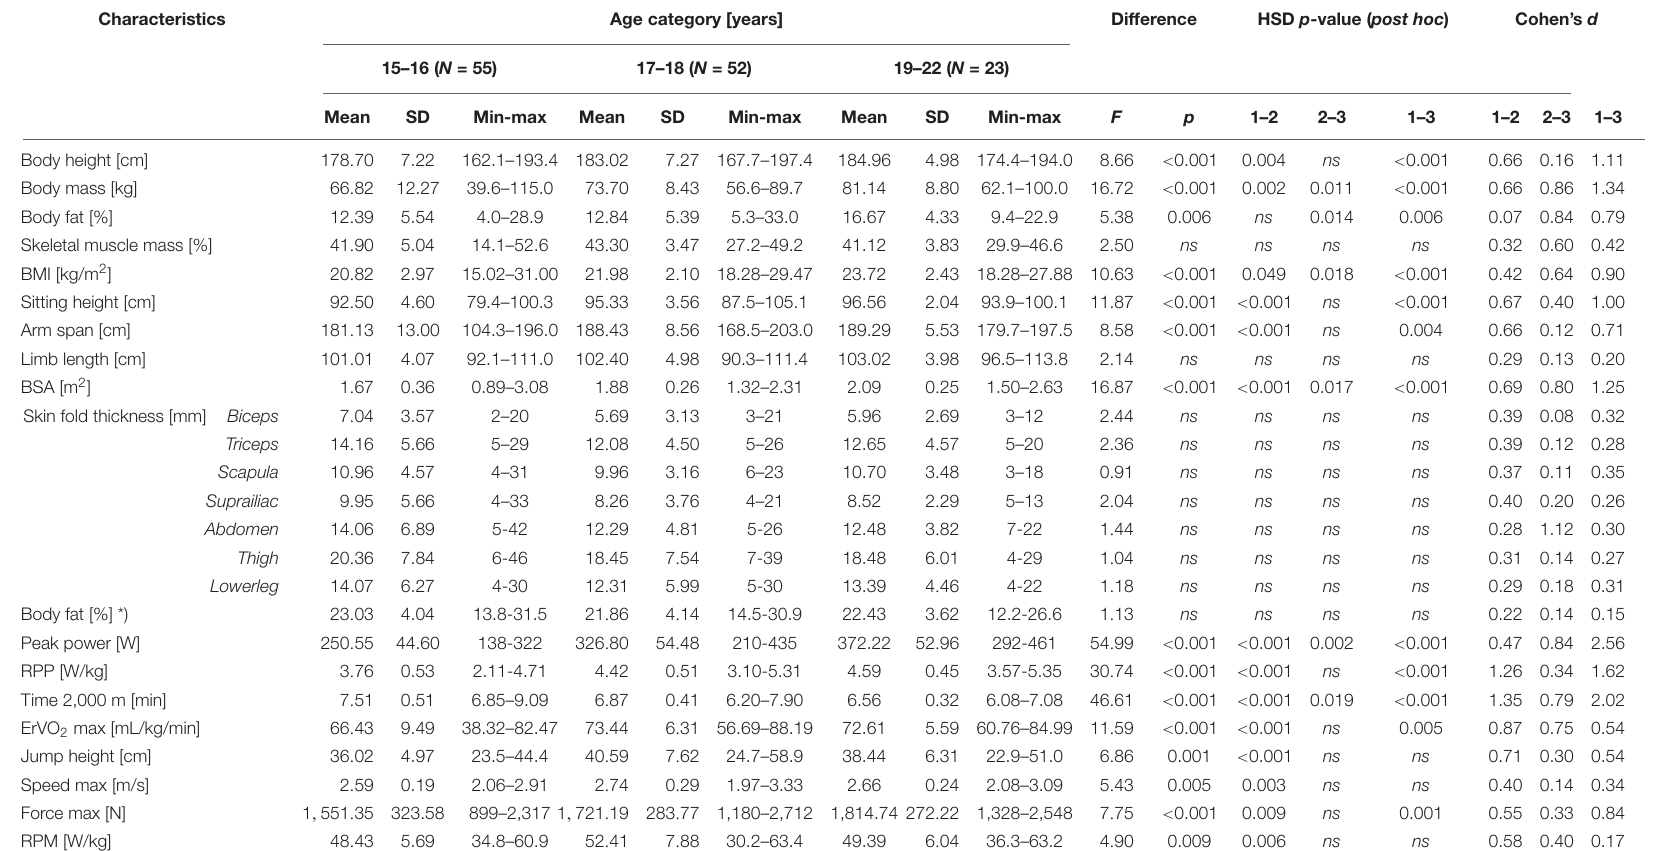
TABLE 1 | Comparison of arithmetic means of men’s anthropometric, physiological and motoric parameters depending on the age categories.